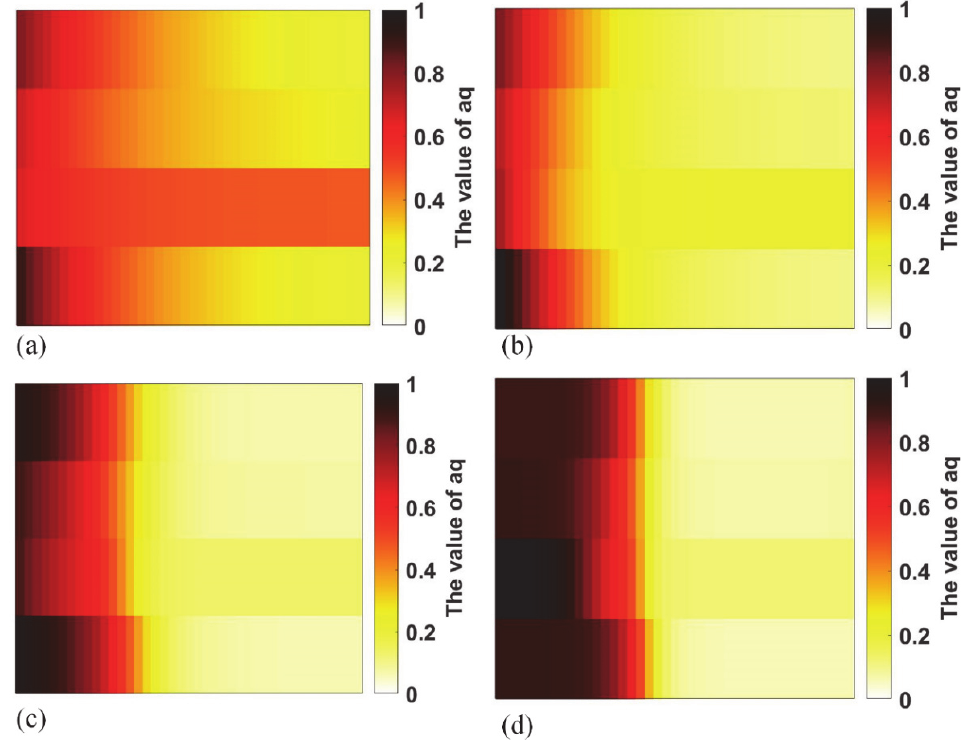
Figure 7. Chromaticity maps of 𝛼(𝑞) with different 𝑞 , ( a ) 𝑞 ∈ [−1,1] . ( b ) 𝑞 ∈ [−2,2] . ( c ) 𝑞 ∈ [−5,5] . ( d ) 𝑞 ∈ [−10,10] .